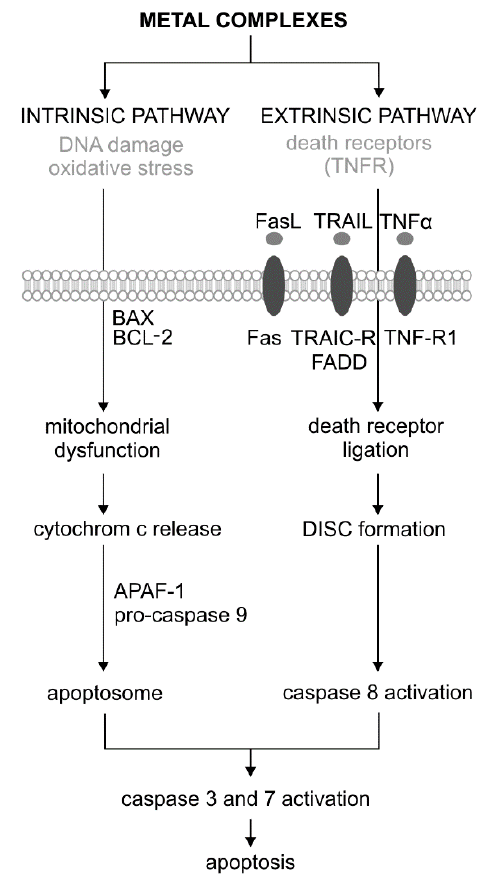
Figure 1. Extrinsic and intrinsic pathways of apoptosis and its activation by the metal complexes adopted [29]. DISC - Death-Inducing Signaling Complex